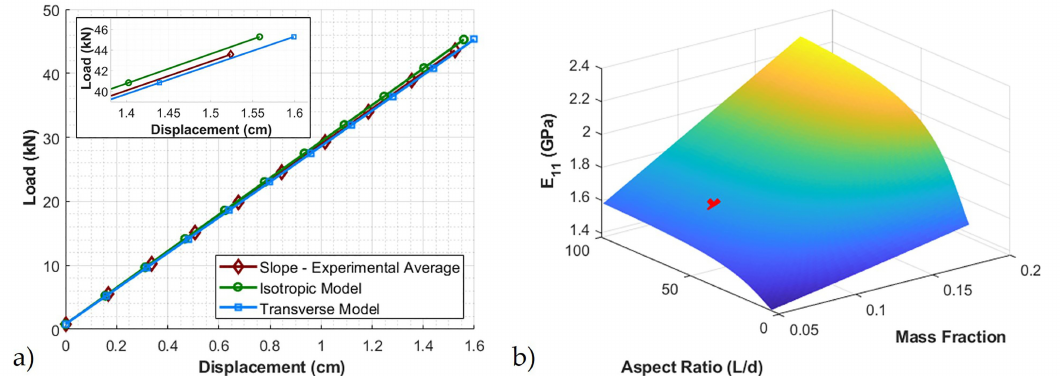
Figure 13. ( a ) Model validation of linear elastic load-deflection with finite element analysis ( b ) effect of elastic modulus with change in aspect ratio and volume fraction of fibers.